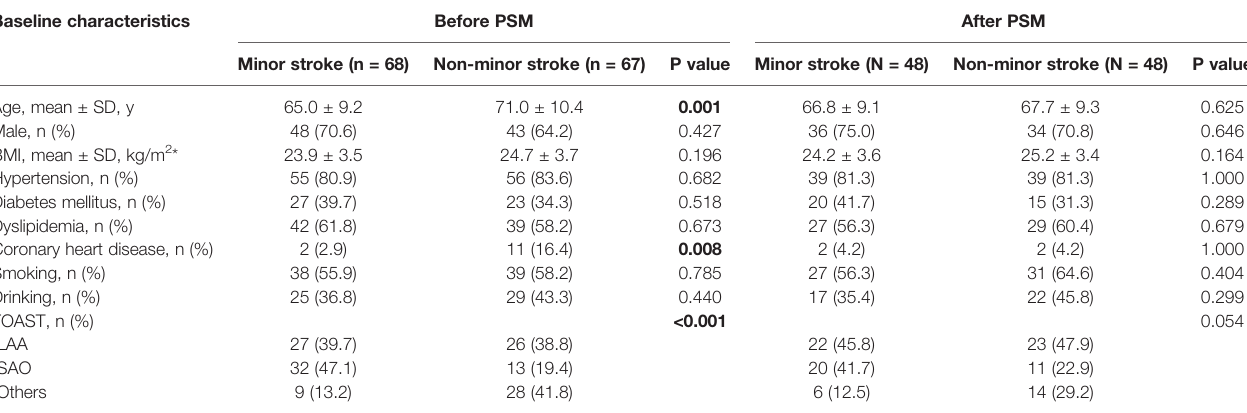
TABLE 1 | Baseline characteristics of patients before PSM and after